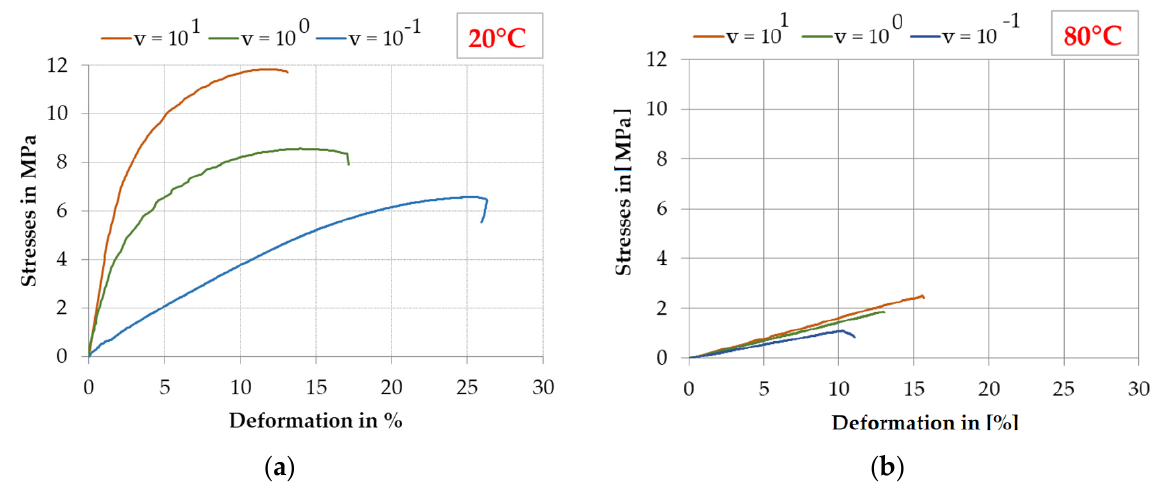
Figure 6. Impact of the test speed on the stress and limit deformation for selected representative specimens of EP 2579-1 adhesive: ( a ) at 20 °C; ( b ) at 80 °C.